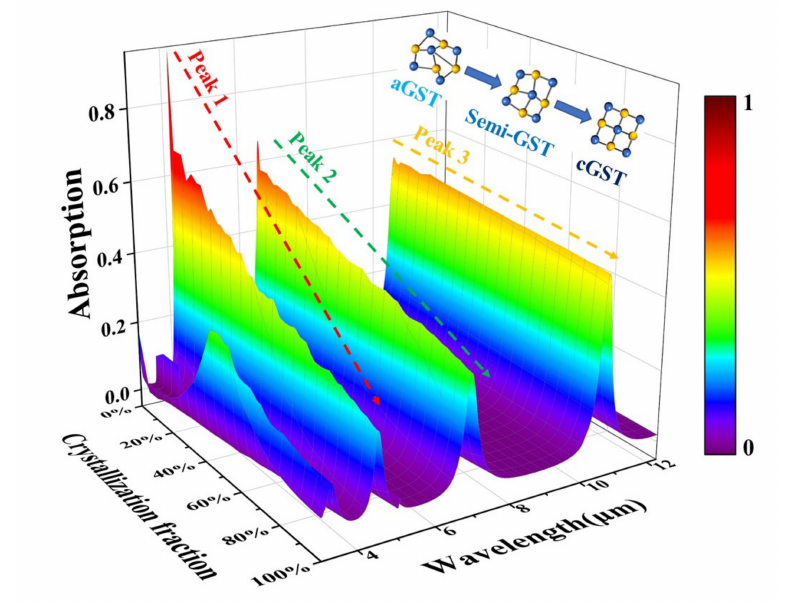
Figure 9. Three-dimensional schematic diagram of the absorbance of the designed five-layer structure as a function of the crystalline fraction of the GST film in the infrared